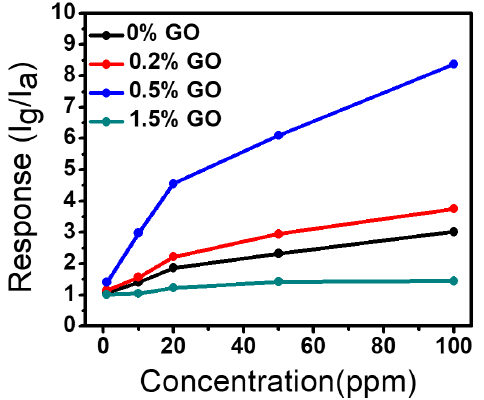
Figure 7. Linear gas response of W 18 O 49 NWs and W 18 O 49 NWs/rGO composites towards different concentrations of toluene vapors at 300 °C.